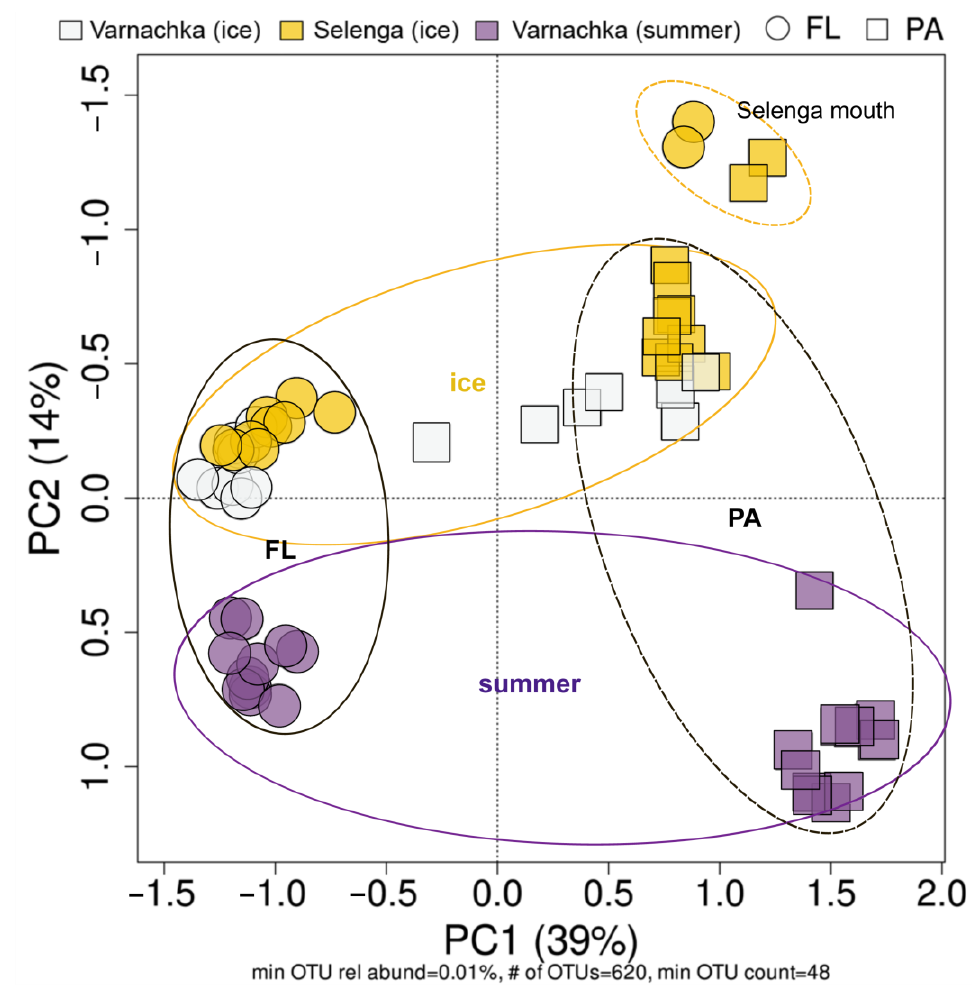
Figure 7. PCoA of FL and PA communities. The yellow oval circles present the communities of the ice-covered period, the yellow dotted oval shows the communities of the Selenga mouth; summer communities are circled in purple oval; community FL is in black oval; community PA is in black dotted oval.